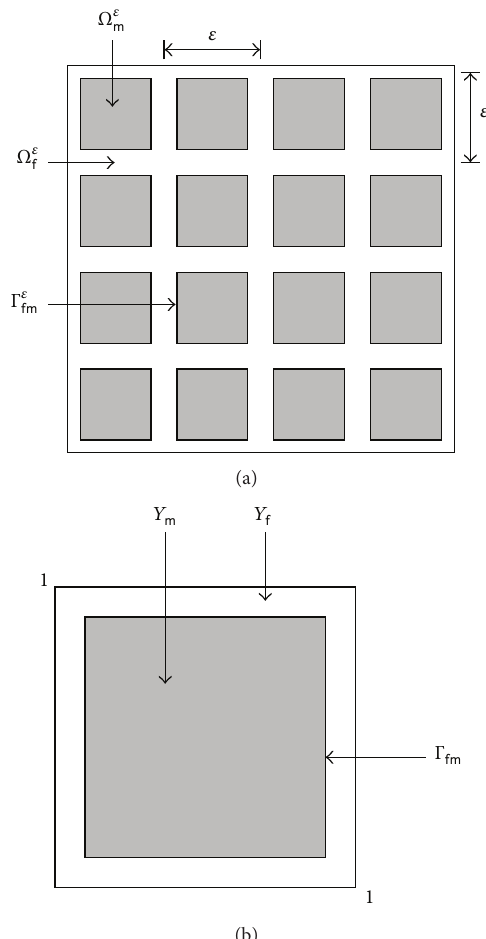
Figure 1: (a) The domain Ω with the mesostructure. (b) The reference cell 𝑌